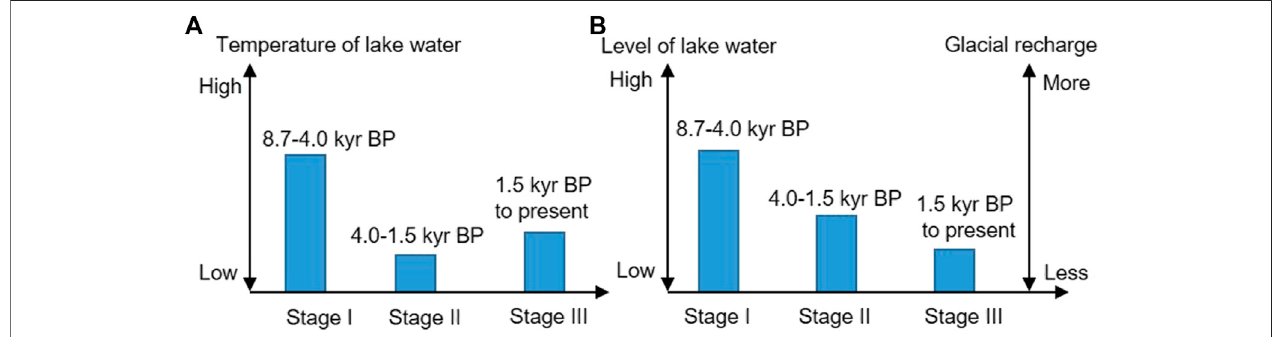
FIGURE 11 | Comparison of data from this study and other records. The δ 18 O of sediments carbonate for Bangong Co and Selin Co are from Gasse et al. (1996) and Gu et al. (1993), respectively. The δ 18 O of cave carbonate for Western Australia and southern China are from Denniston et al. (2013) and Yuan et al. (2004), respectively. Ti/Ca for Indonesia are from Steinke et al. (2014), the reconstructed SST of marine core SK218/1 from the western Bay of Bengal are from Govil and Naidu (2011), and the aragonite data for Bangong Co are from Fontes et al. (1996). The global temperature data are from Marcott et al. (2013).